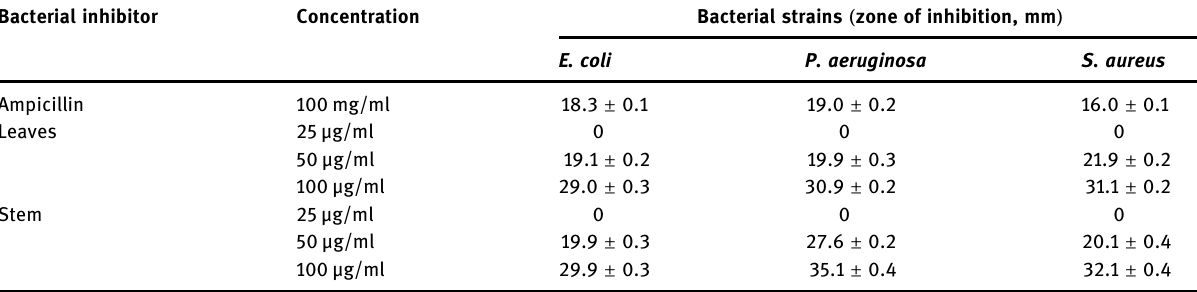
Table 3: Antibacterial activity of EOs of L. umbellata leaves and stem Bacterial